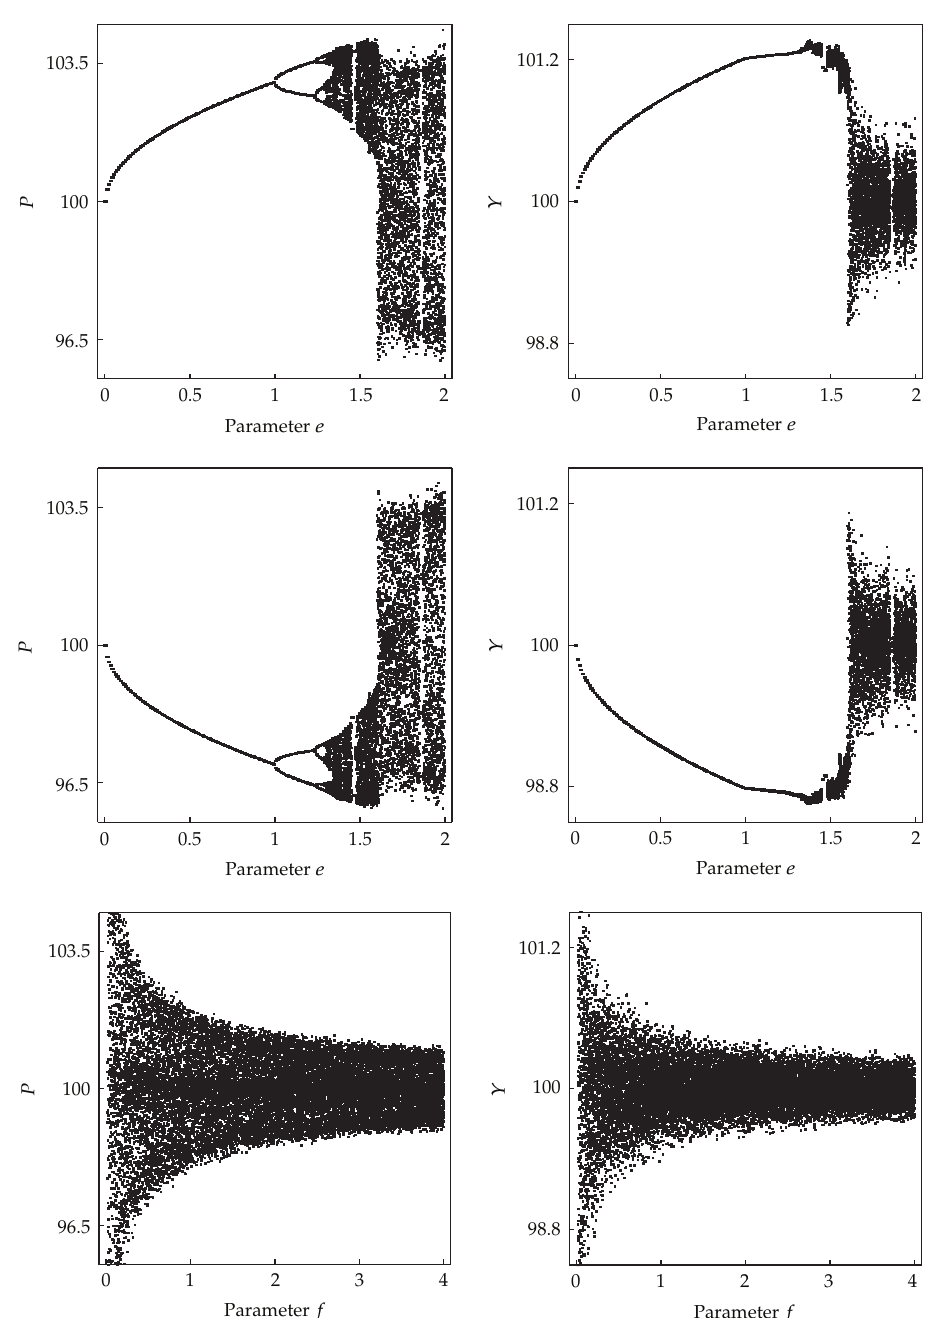
Figure 3: Speculative forces and the dynamics of the complete model. Parameter setting as in Section 4. Bifurcation parameters as indicated on the